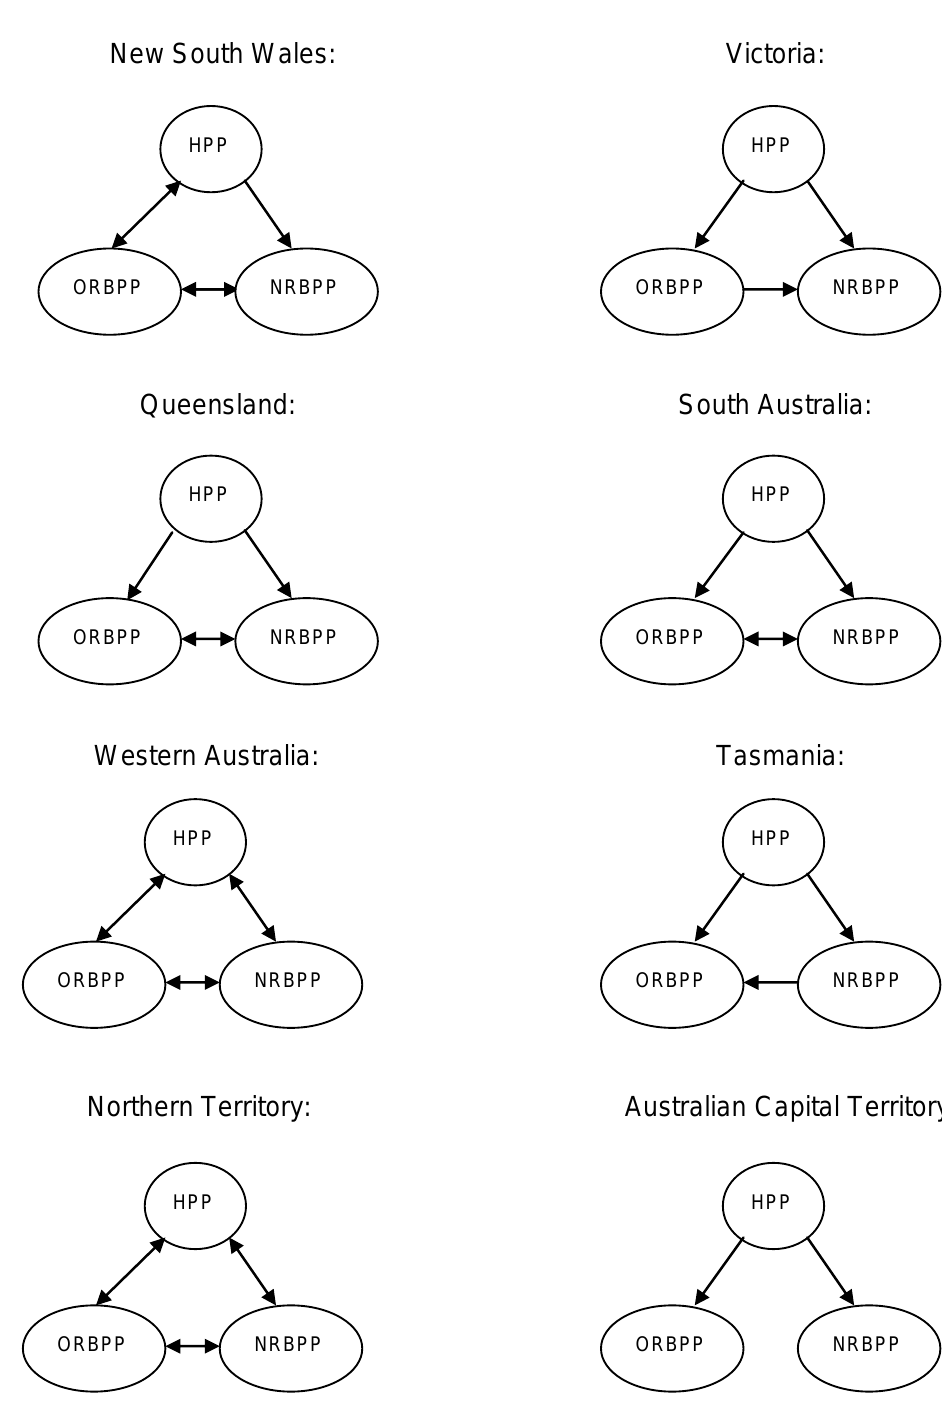
Figure 4: Causal relationships between prices of construction markets in